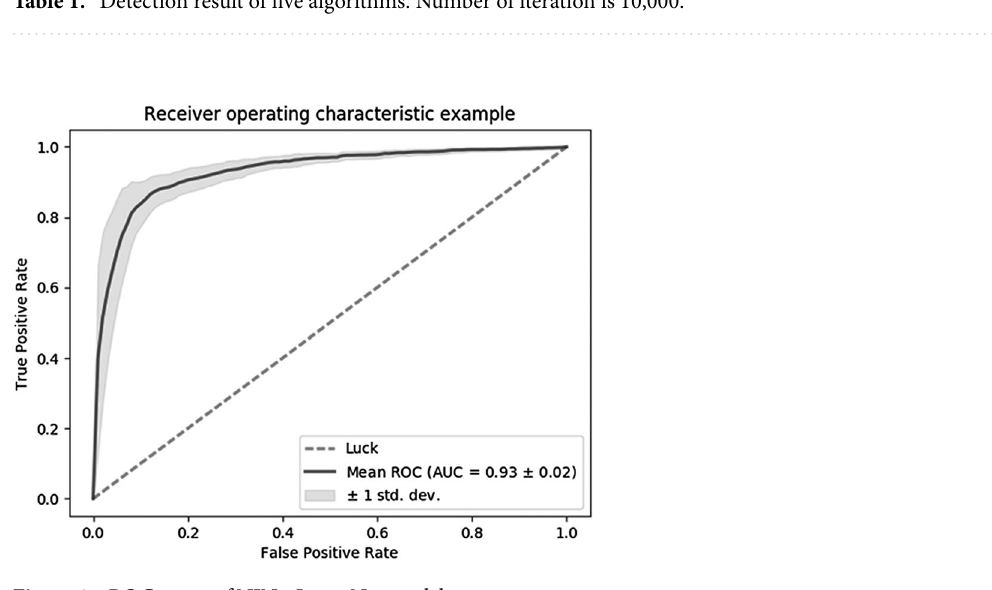
Figure 3. ROC curve of NIN + ImageNet